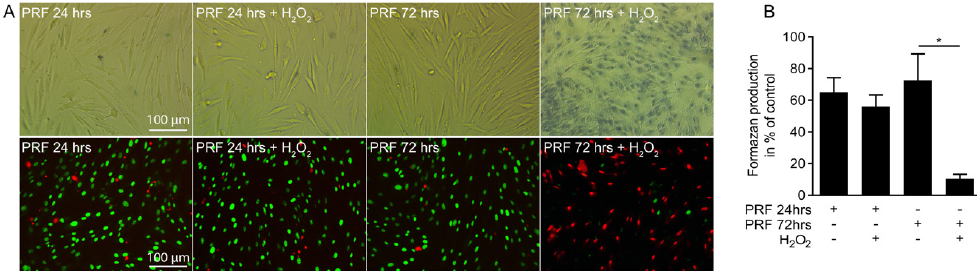
Figure 3. PRF conditioned medium protects cells from necrotic cell death. Gingival fibroblasts (A)